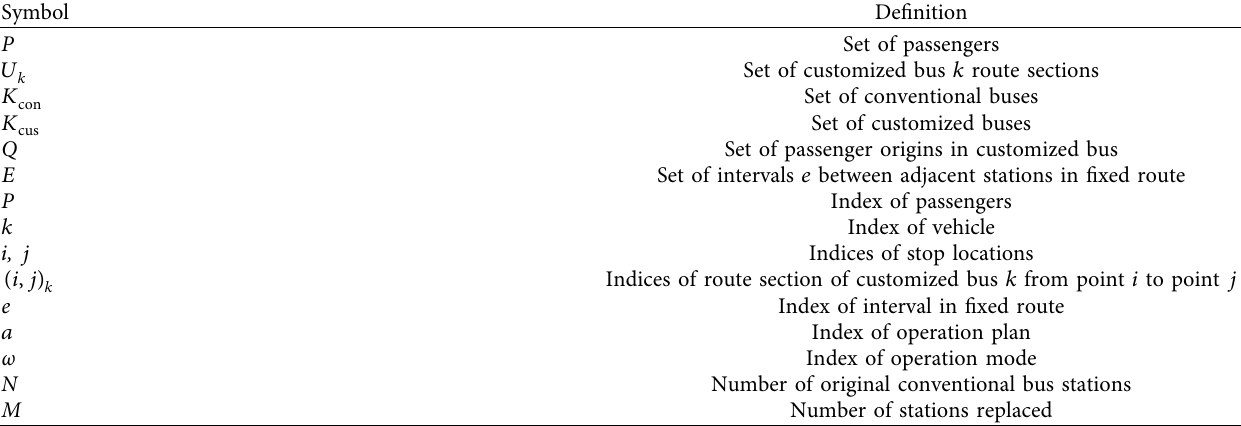
Table 1: The sets, indices, and parameters.